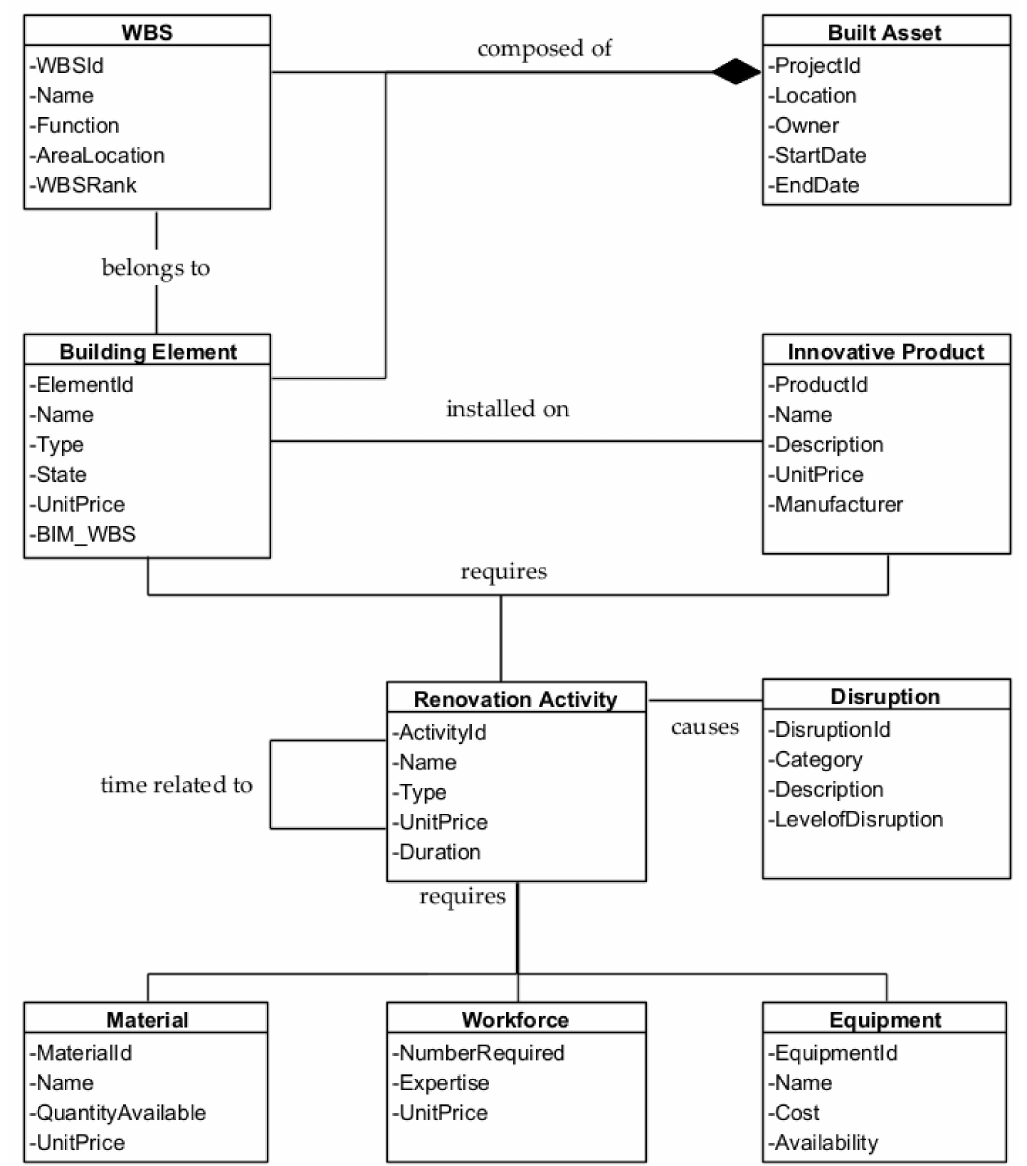
Figure 13. Renovation 4D planning ontology—UML class